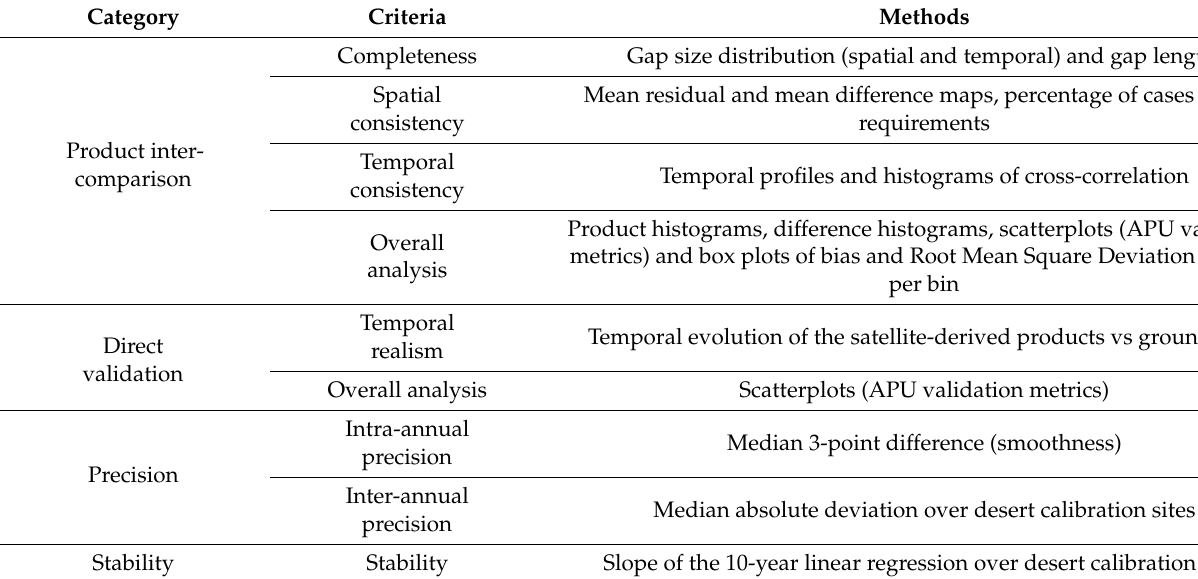
Table 2. Summary of SALVAL validation